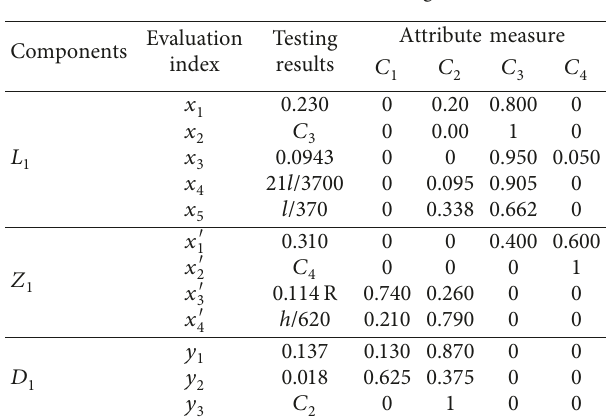
Table 14: Attribute measure of single